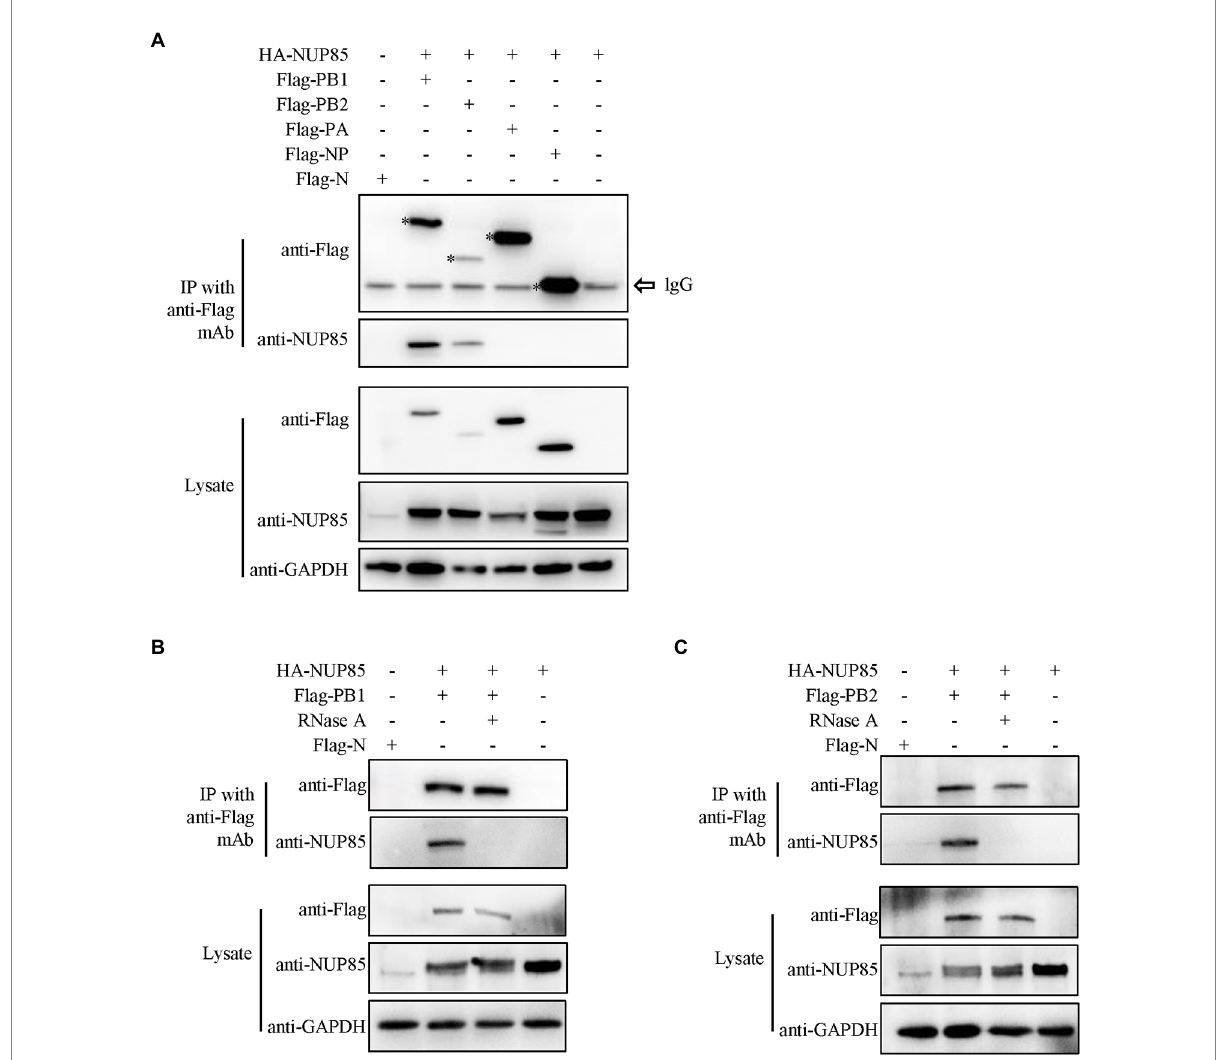
FIGURE 4 Interactions between NUP85 and RNP subunits. (A) HEK293T cells were co-transfected with HA-NUP85 and Flag-PA, Flag-PB1, Flag-PB2, Flag-NP, or Flag-N, respectively. Cells were then lysed at 24 h post-transfection, and immunoprecipitation was performed using anti-Flag antibodies followed by Western blot. (B) HEK293T cells were co-transfected with HA-NUP85 with Flag-PB1 and Flag-N or HA-NUP85, respectively. Cells were lysed and treated the RNase at 24 h post-transfection, and immunoprecipitation was performed using anti-Flag antibodies followed by Western blot. (C) HEK293T cells were co-transfected with HA-NUP85 with Flag-PB2 and Flag-N or HA-NUP85, respectively. Cells were lysed and treated the RNase at 24 h post-transfection, and immunoprecipitation was performed using anti-Flag antibodies followed by Western